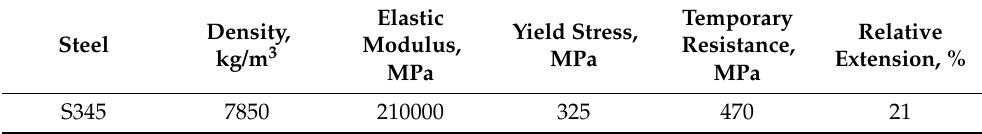
Table 2. Physical characteristics of steel grade S345.